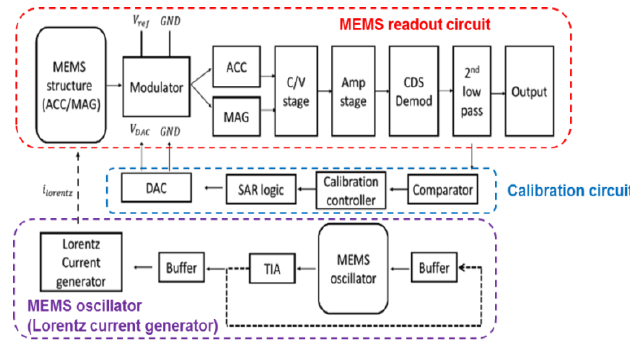
Figure 9. The overall architecture of the proposed readout system.